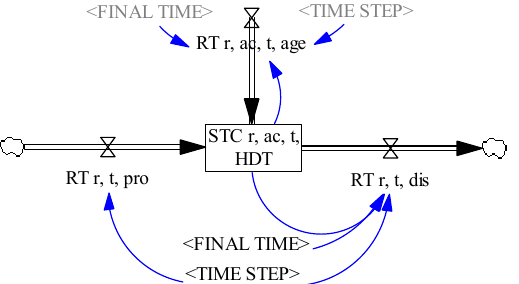
Figure 3. Graphical representation of the HDT stock-and-flow model in the SD modeling software Figure3. VENSIM.